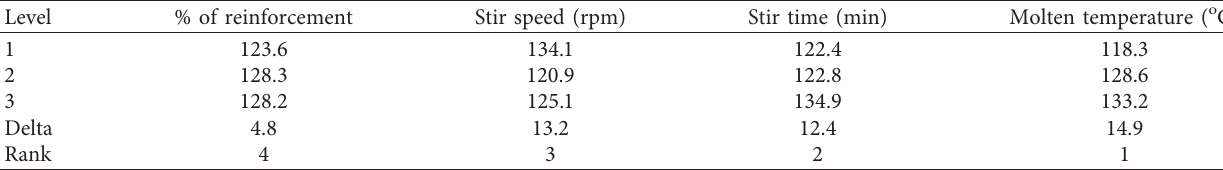
Table 7: Response table for means (microhardness).